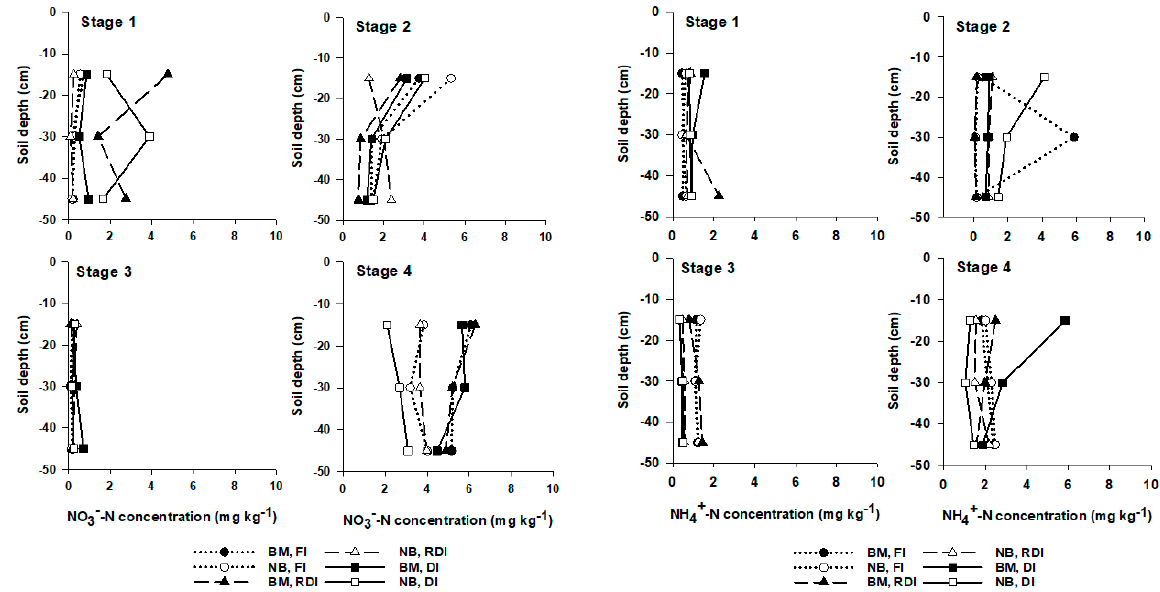
Figure 5. Soil NO 3 − -N and NH 4+ -N distributions as affected by N application timing [(25% pre-plant with 75% fertigation (BM), and zero pre-plant with 100% fertigation (NB)] under full irrigation (FI, 100% ETc), deficit irrigation (DI, 66% ETc) and regulated deficit irrigation (RDI, 66% 0–4 weeks after transplanting and 100% ETc from week 5) during fall 2018 season in Immokalee Florida.